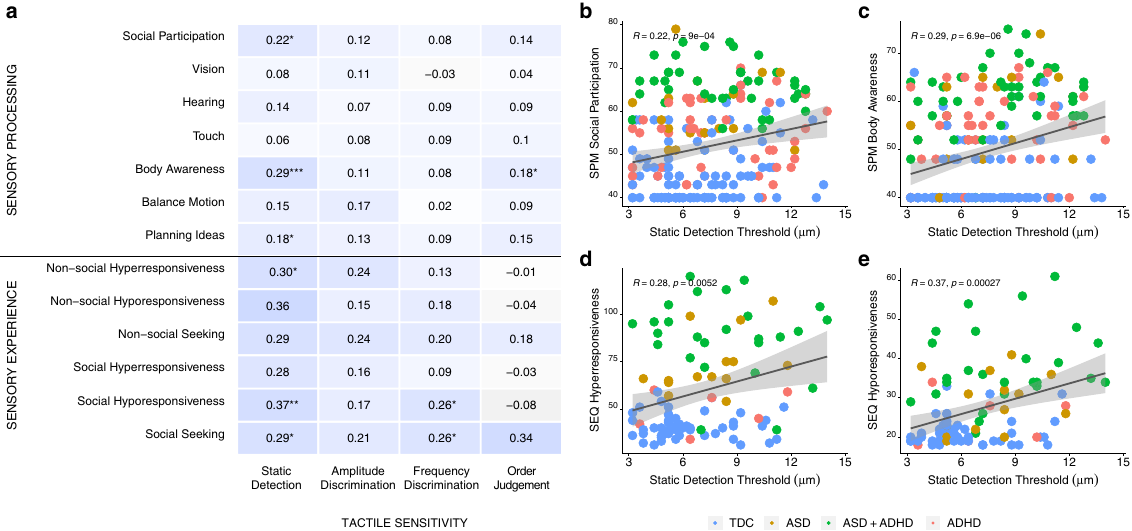
Fig. 6 Correlation analyses between tactile sensitivity thresholds and subscale items from the Sensory Processing Measure and Sensory Experience Questionnaire. a Heatmap correlations between subscales of the Sensory Processing Measure and Sensory Experience Questionnaire ( y -axis) and relevant tactile sensitivity metrics across each subdomain ( x -axis). The “ * ” are used to denote statistical signi fi cance after correcting for multiple correlations using Bonferroni ’ s correction (* p < 0.05, ** p < 0.01, *** p < 0.001). Due to the large number of correlations being conducted, Bonferroni corrections were applied to each of the correlation analyses conducted by multiplying the resulting p -value of each correlation between a given tactile sensitivity metric by the number of subscale items within each questionnaire. For example, for all of the correlations conducted between the Sensory Processing Measure and static detection thresholds, the resulting p -value was multiplied by 7 (i.e., number of subscale items within the Sensory Processing Measure). It is clear that the tactile sensitivity metric that was most often associated with the subscale items of the Sensory Processing Measure and Sensory Experience Questionnaire questionnaires was static detection thresholds. On the right we highlight the correlations between static detection thresholds and b social participation, c body awareness, d hyper-responsiveness and e hypo - responsiveness. Note that the scatterplots presented in d and e are using combined scores of social and non-social hyper-responsiveness and hypo-responsiveness (which are otherwise presented individually on the heatmap in a . See Supplementary Results, Supplementary Fig. 7 for additional correlation analyses. Note that the p -values (* p < 0.05, ** p < 0.01, *** p < 0.001) presented within each scatterplot are the unadjusted p -values. TDC typically developing controls, ASD autism spectrum disorders, ADHD attention-de fi cit hyperactivity disorder, RT reaction times, SPM sensory processing measure, SEQ sensory experience